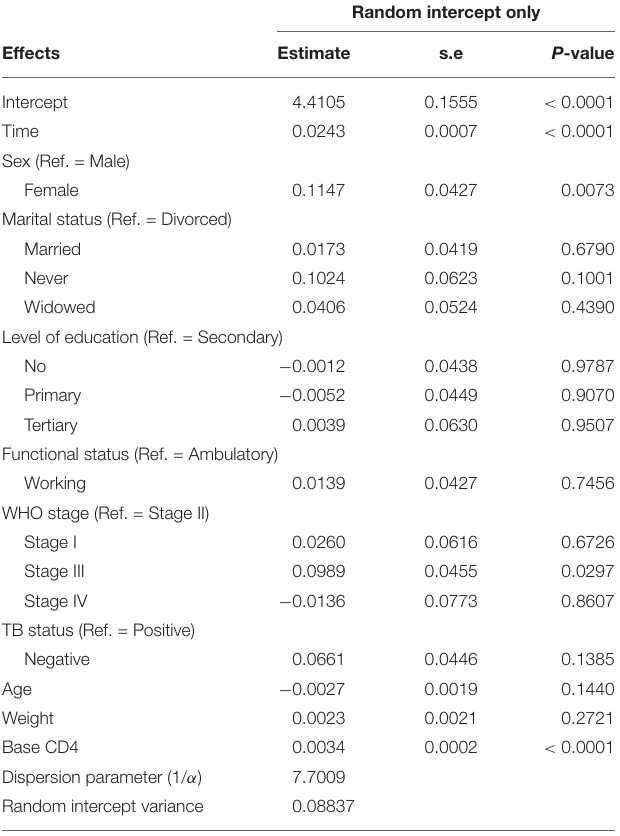
TABLE 8 | Poisson-Gamma-Normal